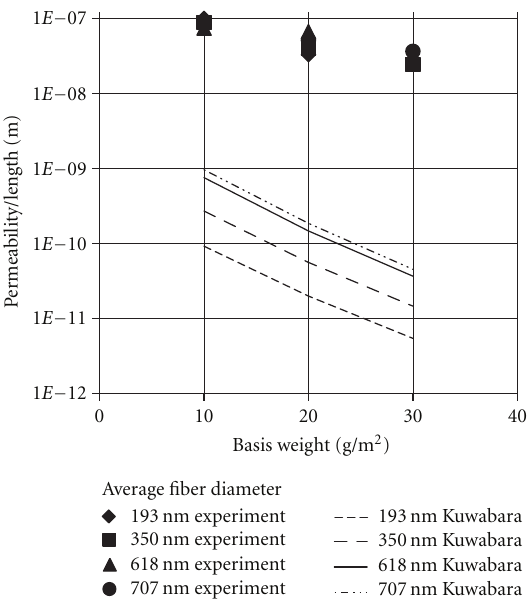
Figure 9: Experimental data plotted in comparison to the calcu- lated values using the Kuwabara